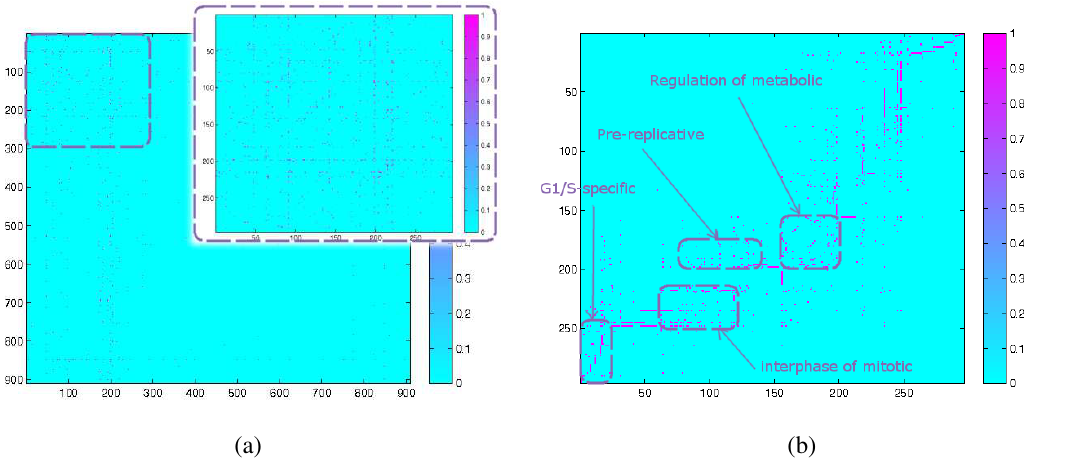
Figure 3: (a) The adjacency matrix of the inferred network, the part in dash frame corresponds to cell cycle specific sub-network, (b) The modularized adjacency matrix of the cell cycle specific